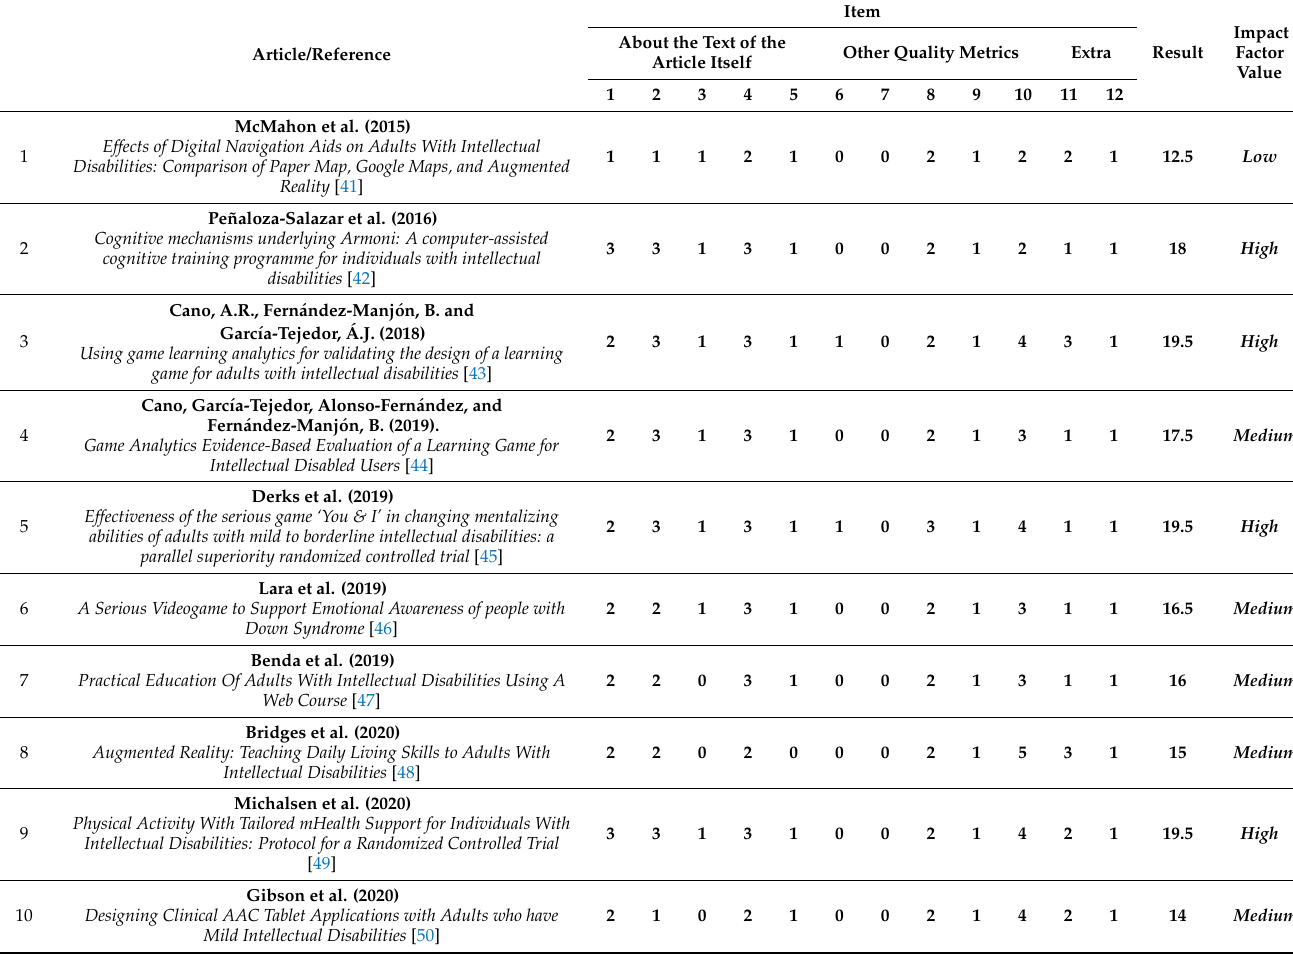
Table 4. Quality analysis of selected articles including executive and cognitive